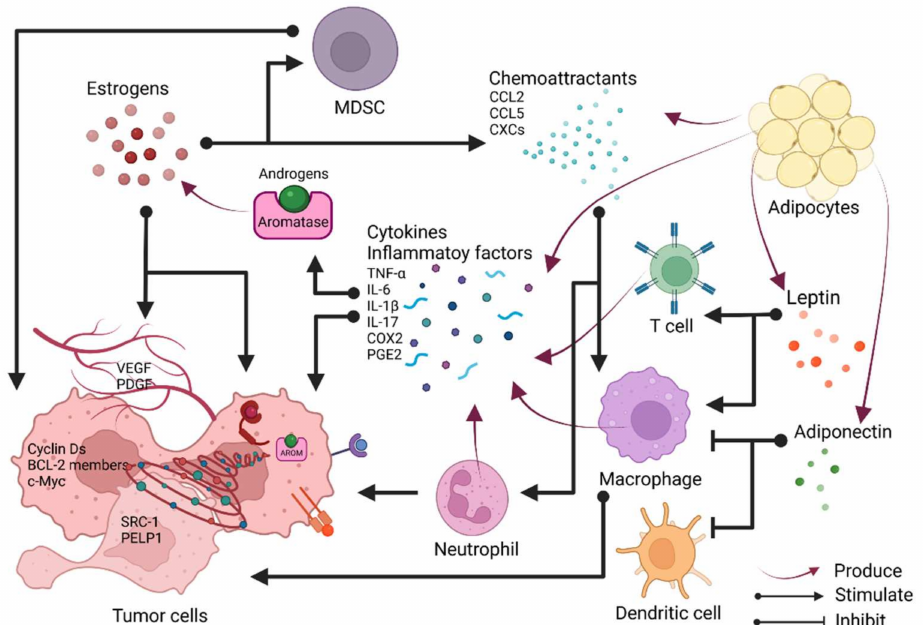
Figure 2. Schematic depiction of the tumor microenvironment of breast cancer. Tumor cells, infiltrated immune cells, and adipocytes are highlighted in this schematic graph. Estrogens drive tumor cell proliferation and metastasis via transcriptional activation of cyclin Ds, anti-apoptotic factors, SRC-1, and PELP1. Estrogens also promote angiogenesis via VEGF and PDGF. Cytokines such as TNF α , IL-6, andIL-1 β and inflammatory components are released mainly by infiltrated immune cells. They increase the activity of aromatase and thus elevate the estrogen level, and they also directly impact the growth of tumor cells via receptors. Estrogens elevate chemoattractant levels and thus facilitate the infiltration of MDSC, neutrophil and macrophage which then promote tumor growth. Adipocytes secrete inflammatory factors and leptin, which stimulate T cells and macrophages to produce more cytokines, forming a positive feedback, while adiponectin can inhibit immune